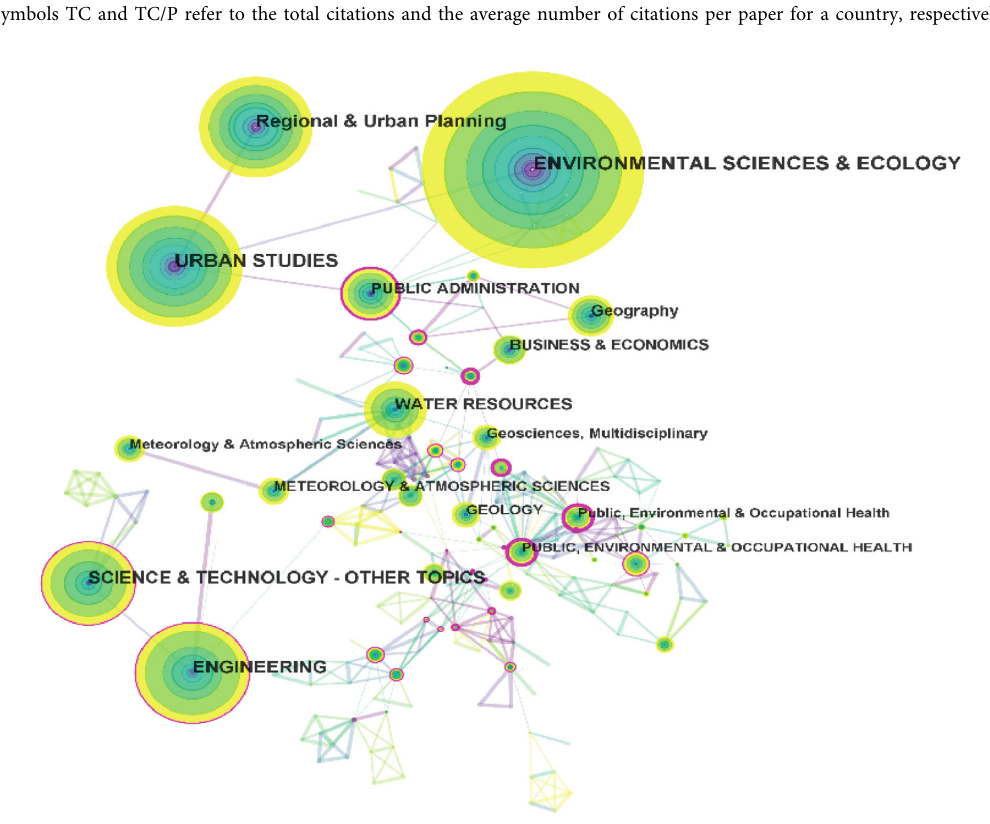
Figure 5: Visualization map of subject categories in resilient city research from 2010 to